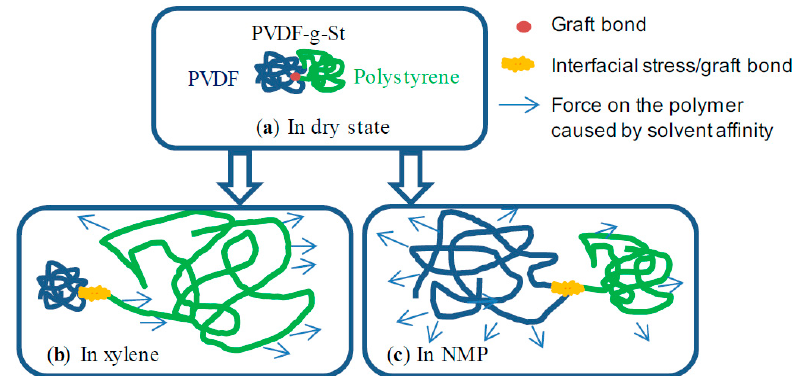
Figure 11. Cleavage mechanism of PVDF– g –St in dry state ( a ) and in solvents of xylene ( b ) and NMP ( c ). In xylene, the polystyrene chains tend to dissolve in solution while the PVDF chains tend to shrink. In NMP both the polystyrene and PVDF chains dissolve in solution but NMP are better solvent for PVDF chains than for polystyrene chains. The arrows refer to the force caused by interaction of the polymer chains and solvent